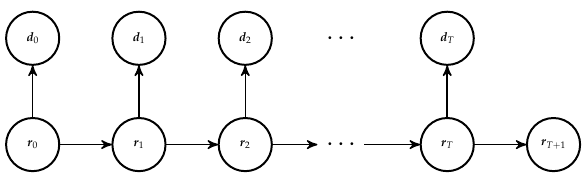
Figure 1. Graph of the hidden Markov